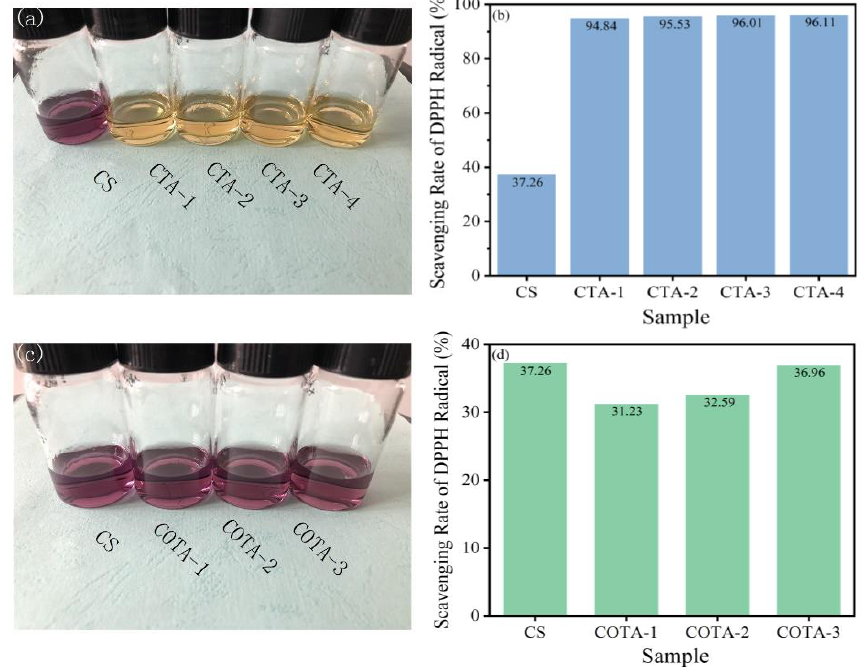
Figure 12. ( a ) Digital images of DPPH radical scavenging activity of CS and CTA films; ( b ) activity of CS and CTA films in scavenging DPPH radicals; ( c ) digital images of DPPH radical scavenging activity of CS and COTA films; ( d ) activity of CS and COTA films in scavenging DPPH radicals.